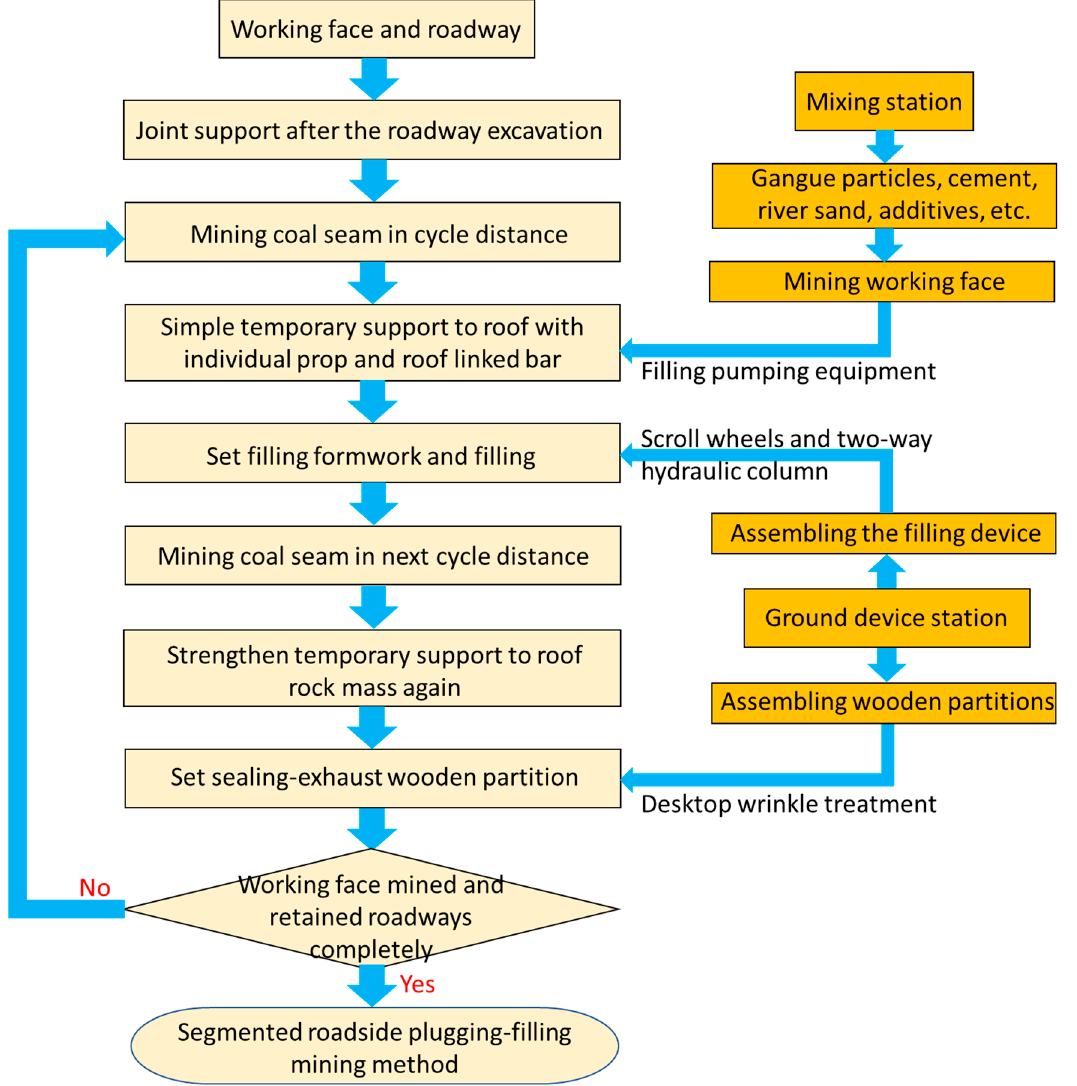
Figure 6. Mining process of SRPF.